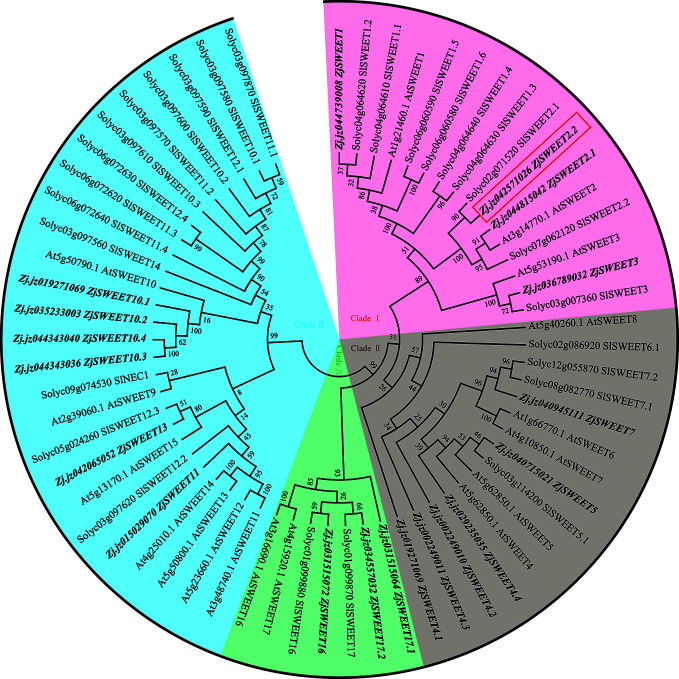
Maximum likelihood phylogeny of SWEET sugar transporters. Accession numbers for SWEET genes from Arabidopsis are those reported by Wei et al. (2014) and those for tomato genes are those reported by Feng et al. (2015).